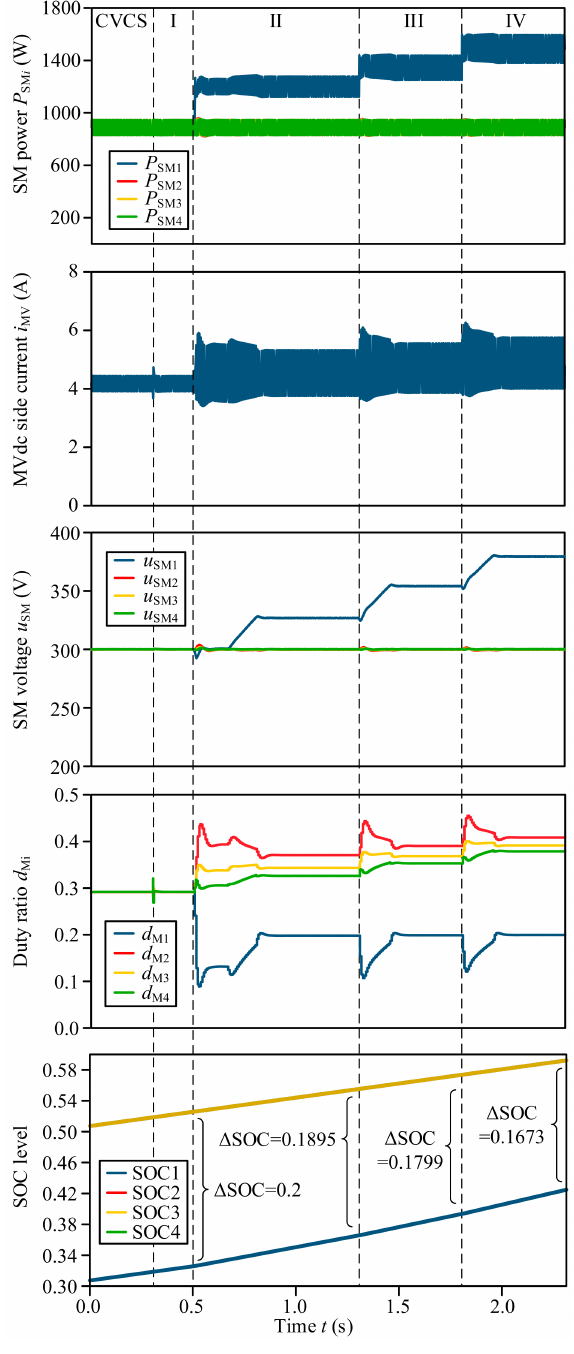
Figure 5. Simulation results of the proposed MMC-driven